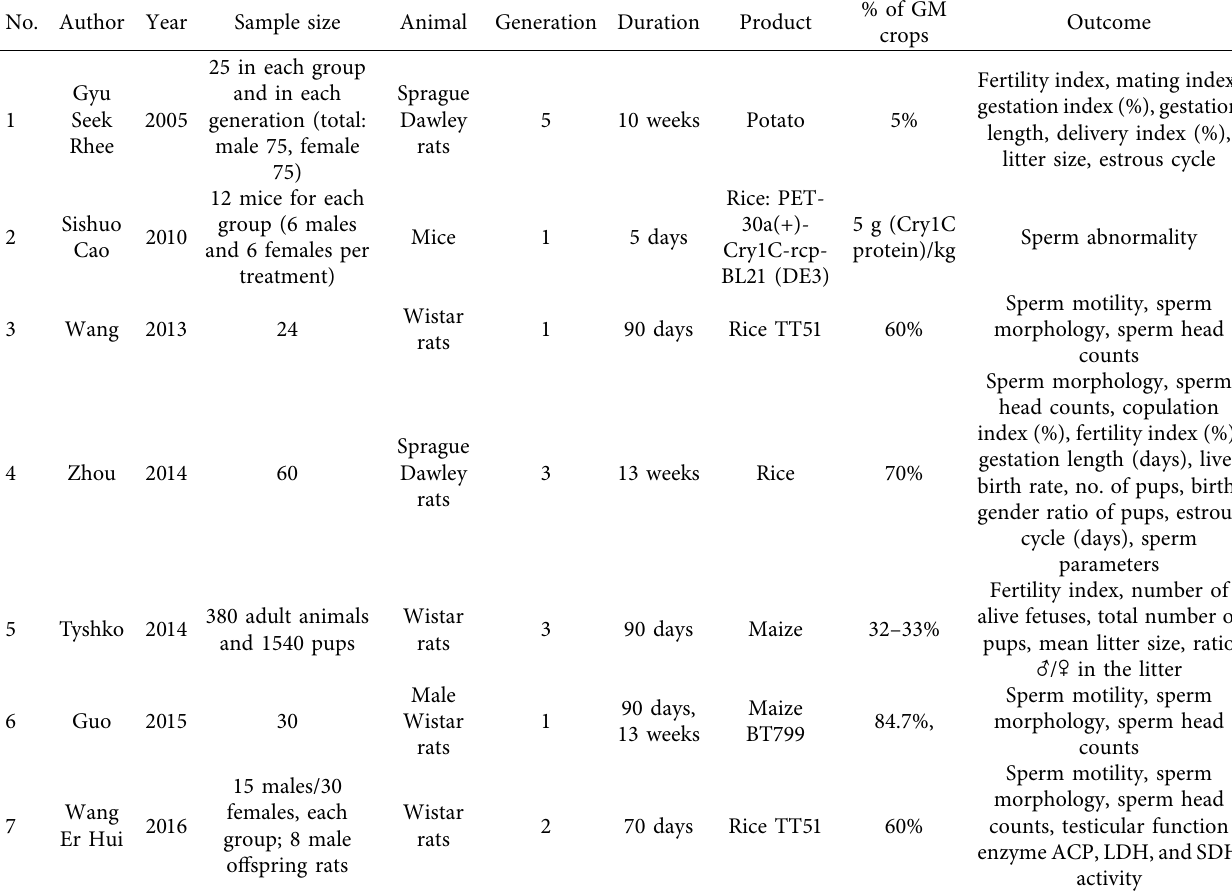
Table 1: Characteristics of the studies on the effects of genetically modified crops on animal’s